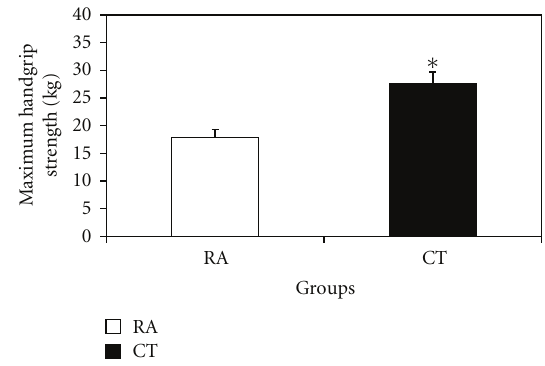
Figure 1: Handgrip strength in RAs and CTs expressed in kg. ∗ P < 0 . 05 versus CTs.